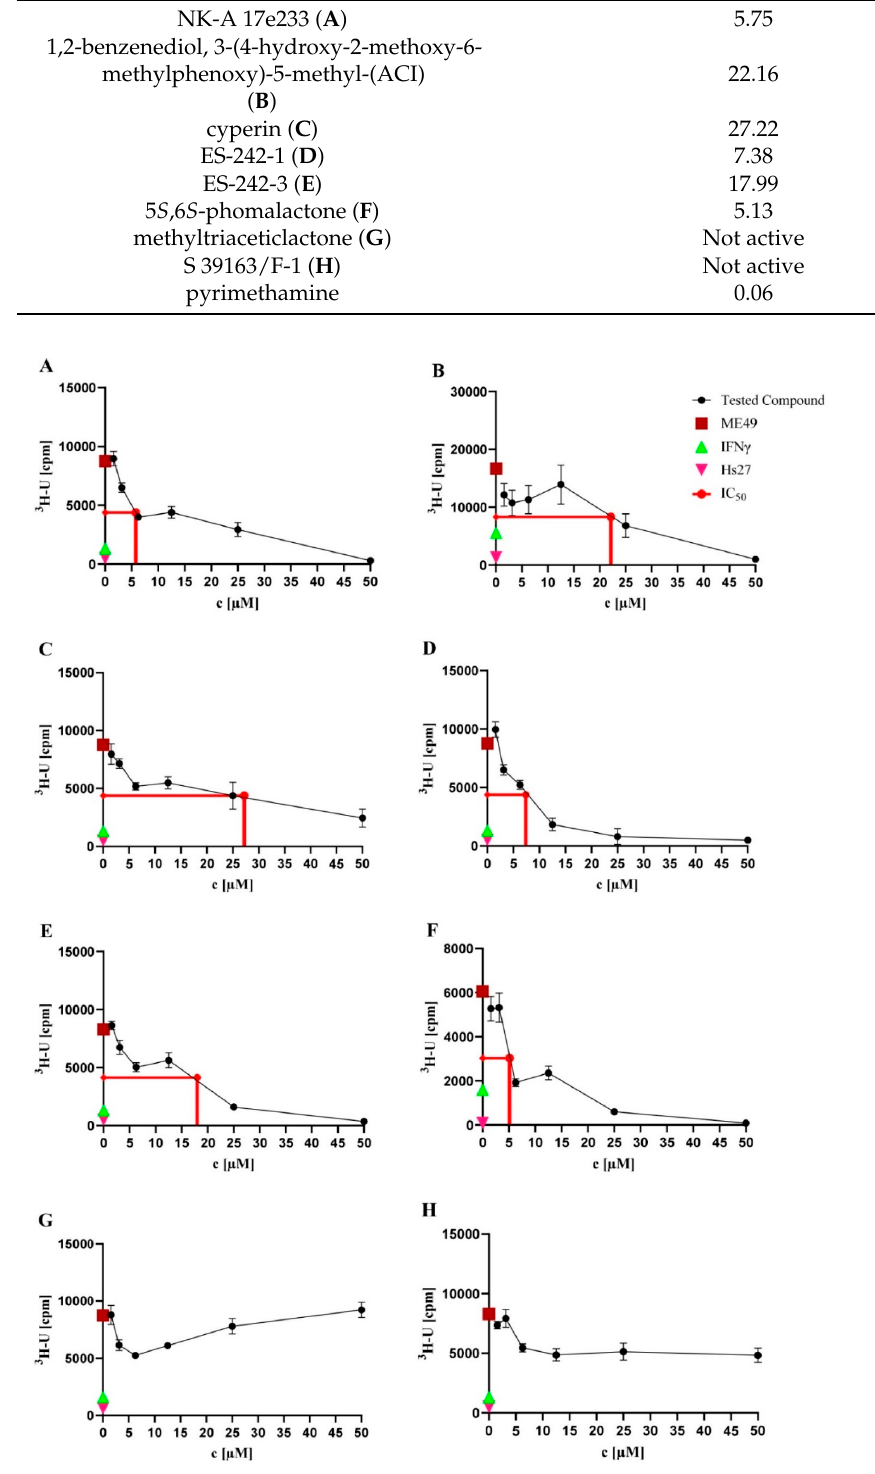
Figure 3. Toxoplasma proliferation assays. Toxoplasma proliferation assays were performed to investigate the activity of the natural products against T. gondii strain ME49. Hs27 cells were cultured in a monolayer in 96-well plates and infected with T. gondii (3 × 10 4 ). Cultures were treated with the natural products at the concentration range of 0.56–50.00 µM for 48 h at 37 °C. Afterwards, the cultures were labelled with 3 H-U (5 mCi, diluted 1:30) for 28–30 h at 37 °C. Based on the incorporation of 3 H-U into the parasite nucleic acid, the parasite growth was quantified. As controls, uninfected Hs27 cells without treatment (pink triangles) and IFN γ pre-stimulated infected Hs27 cells (green triangles) were used, while untreated T. gondii- infected Hs27 cells (red squares) served as a negative control. Values shown in ( A – H ) represent the means of three independent experiments each done in duplicate ( n = 6) ± SEM. The mean of the IC 50 values (red line) of each compound is shown. Activity of NK-A 17e233 ( A ); 1,2-benzenediol, 3-(4-hydroxy-2-methoxy-6-methylphenoxy)-